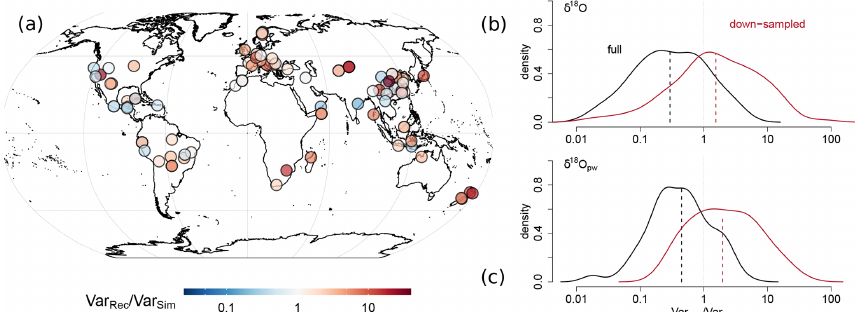
Figure 5. (a) Spatial visualization of the site-based dimensionless variance ratio V Rec /V Sim , where the simulated δ 18 O is down-sampled to record resolution, based on LM1. Aggregated density plots of the variance ratio of δ 18 O (b) and precipitation-weighted δ 18 O pw (c) for the raw records (“full”, black lines). The simulation has also been down-sampled to the record resolution (“down-sampled”, red lines), which illustrates the variance loss due to temporal averaging in the archive (uses LM1-3).